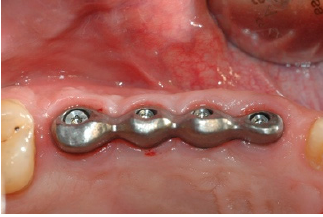
Figure 9. Mesostructure test.